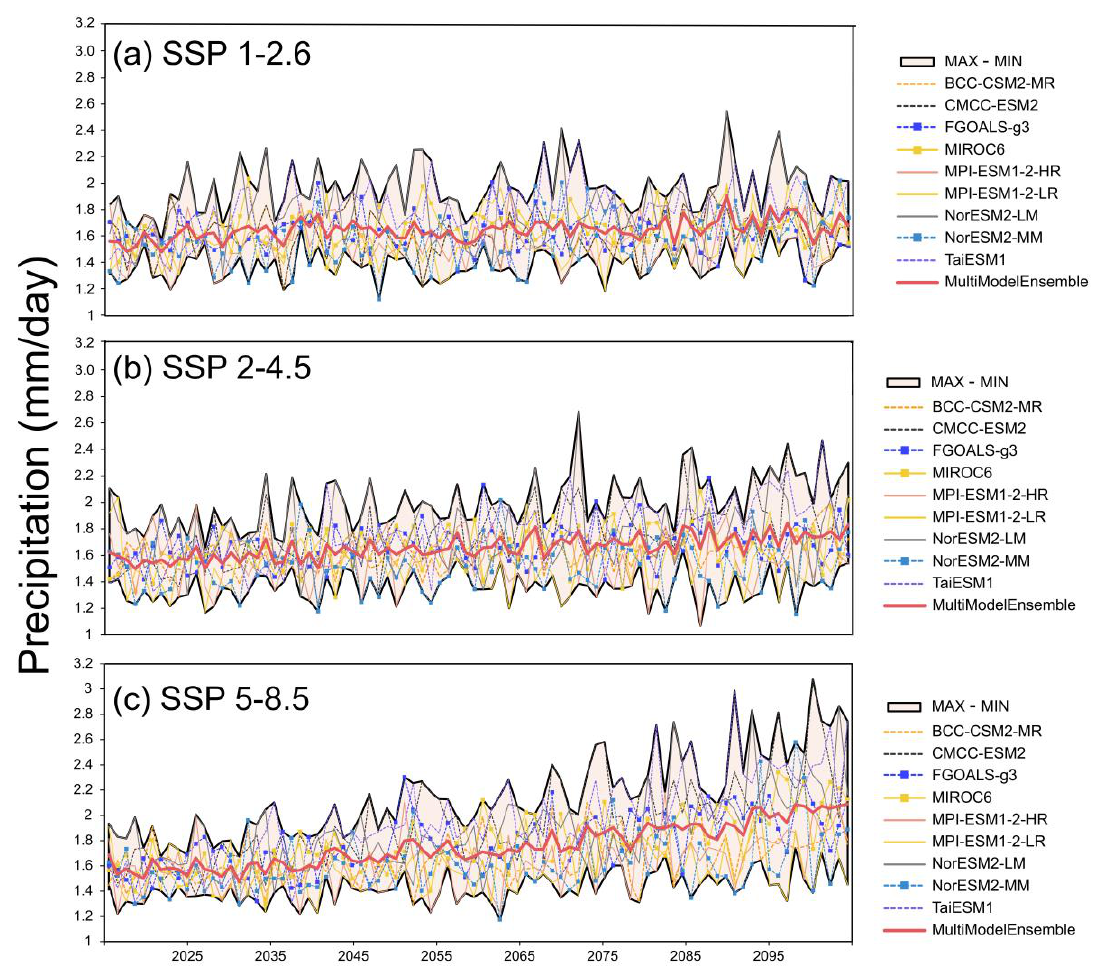
Figure 8. Annual average precipitation for each model and MME from 2015 to 2100.